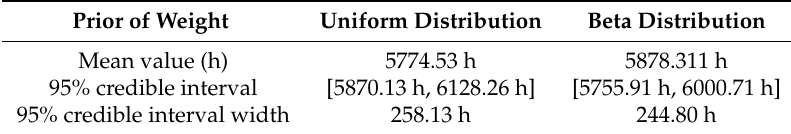
Table 5. Comparisons for different